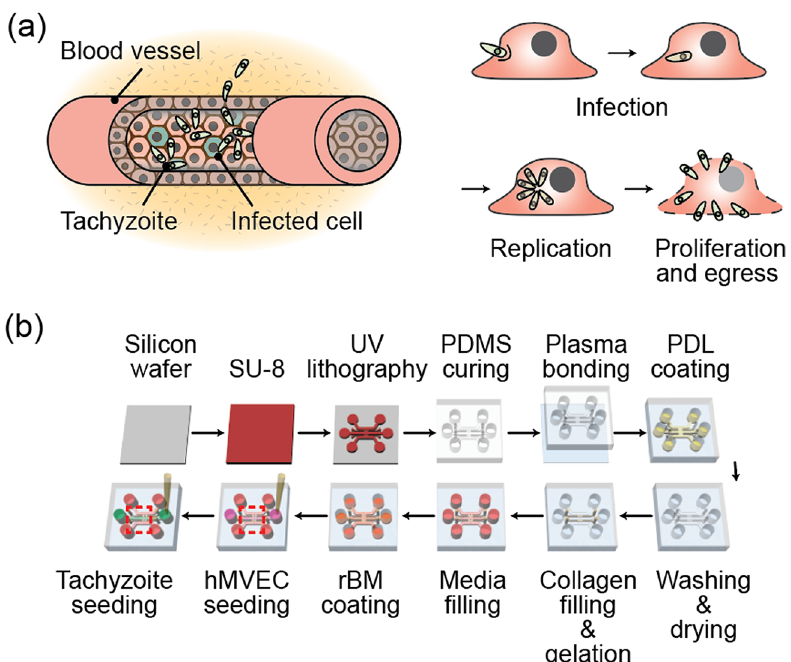
Figure 1. ( a ) Diagrams showing the infection of a blood vessel by a tachyzoite. After penetrating the cell membrane, the tachyzoite relicates inside the cell and then egresses. ( b ) Pictorial representation of the manufacturing process for the microfluidics platform used in the